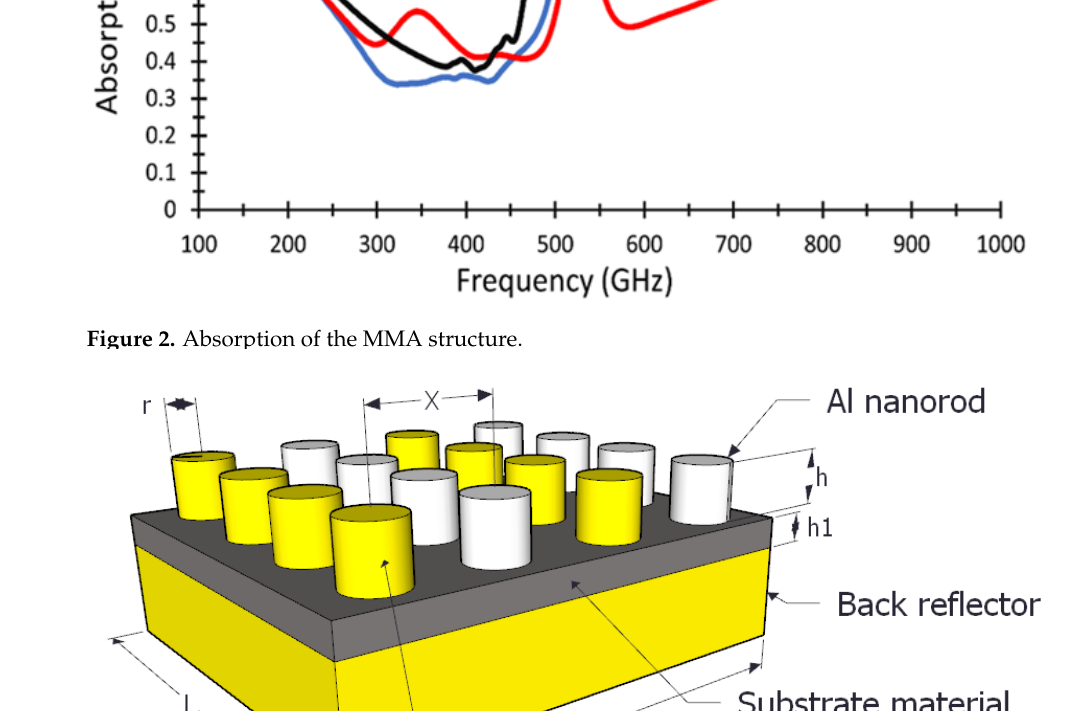
Figure 3 . Schematic diagram of the MMA structure with alternating rows of Au, and Al.